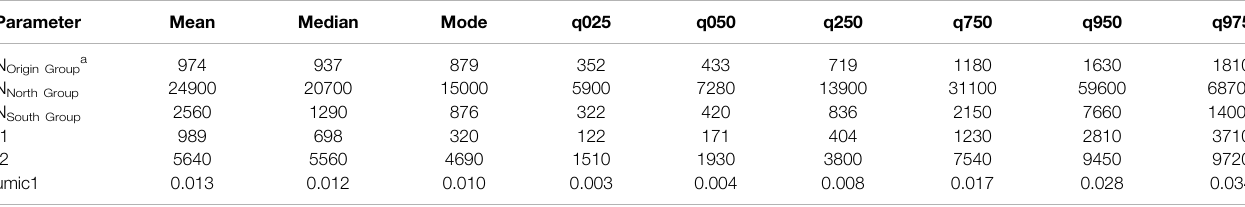
TABLE 4 | DIYABC analyses of trees genotyped in the Pyrus calleryana dataset for the evolutionary scenario 6.